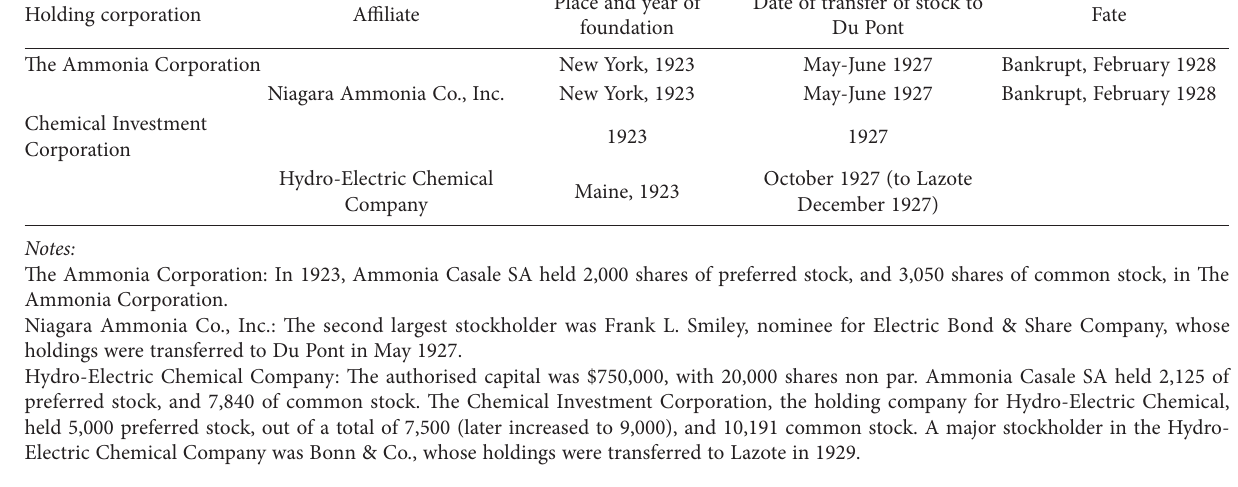
Table 2. Ammonia Casale SA investments in the United States, 1923-1927. Holding